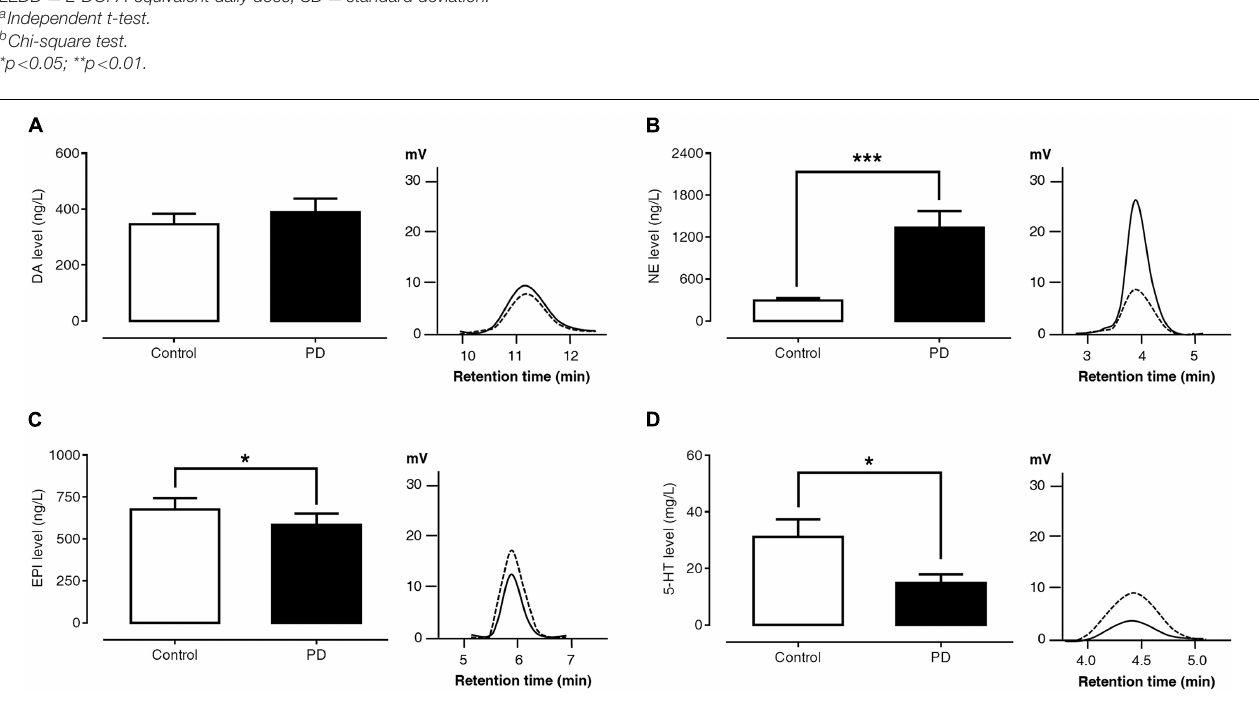
In contrast, the VMA/NE ratio of PD patients was significantly lower than that of control subjects (0.021 ± 0.004 versus 0.045 ± 0.007, p < 0.001). The ratios of VMA/EPI (0.039 ± 0.009 versus 0.016 ± 0.002, p = 0.29) and 5-HIAA/5-HT (0.804 ± 0.315 versus 1.171 ± 0.514, p = 0.74) were not significantly